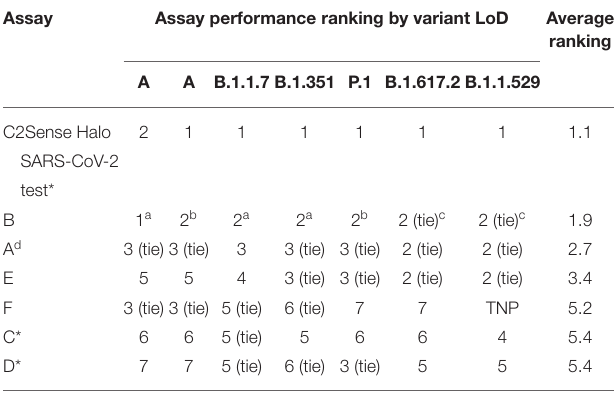
TABLE 2 | SARS-CoV-2 lateral flow immunoassay performance rankings. Assay Assay performance ranking by variant LoD Average